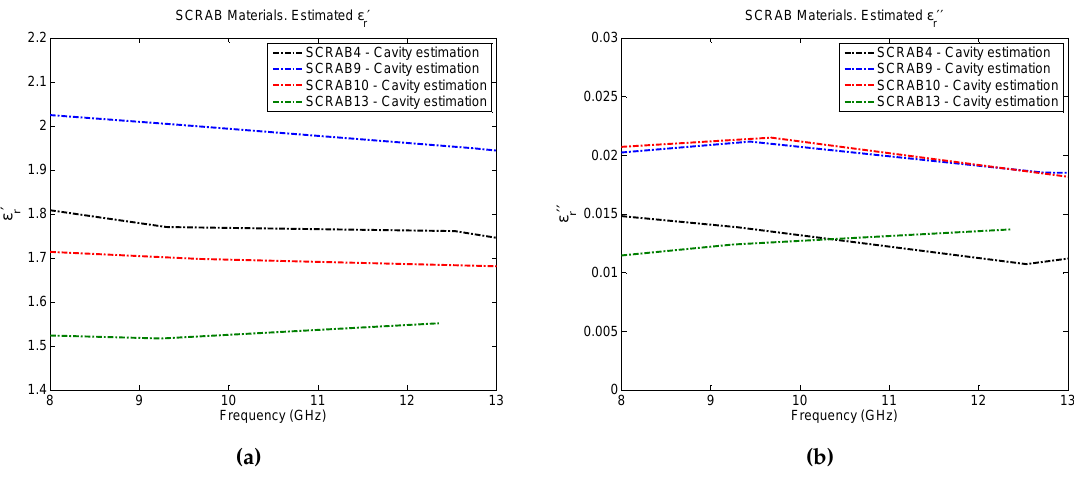
Figure 10. SCRAB-II materials estimated permittivity with split cavity resonator: ( a ) (cid:101) (cid:48) r ( b ) (cid:101) (cid:48)(cid:48) r